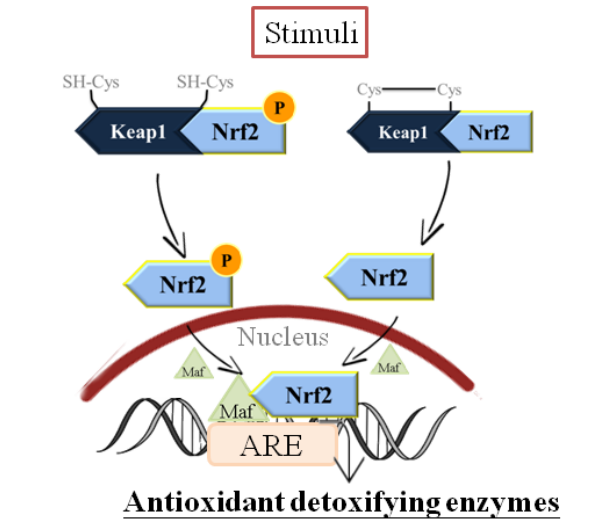
Figure 1. Nuclear factor (erythroid-derived 2)-like 2 (Nrf2) serves as the chief transcription factor orchestrating antioxidant response in terms of binding to antioxidant response element (ARE) located in the promoter region, transcribing genes encoding phase II detoxifying antioxidant enzymes and several detoxifying proteins.